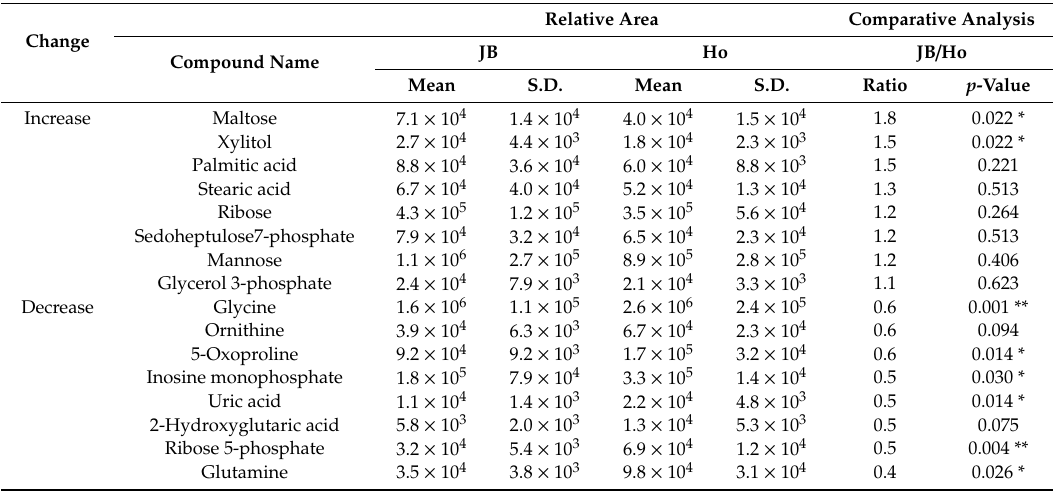
Values are expressed as means and S.D. ratio: fold intensity of metabolite compounds (JB/Ho). Annotation and relative quantification of metabolites was measured by each peak using the gas chromatography–mass spectrometry (GC-MS) solution (Shimadzu) and GC/MS Metabolite Database Ver. 2 (Shimadzu). Japanese Black Wagyu (JB, n = 4), Holstein (HO, n = 4) * p < 0.05, ** p < 0.01.